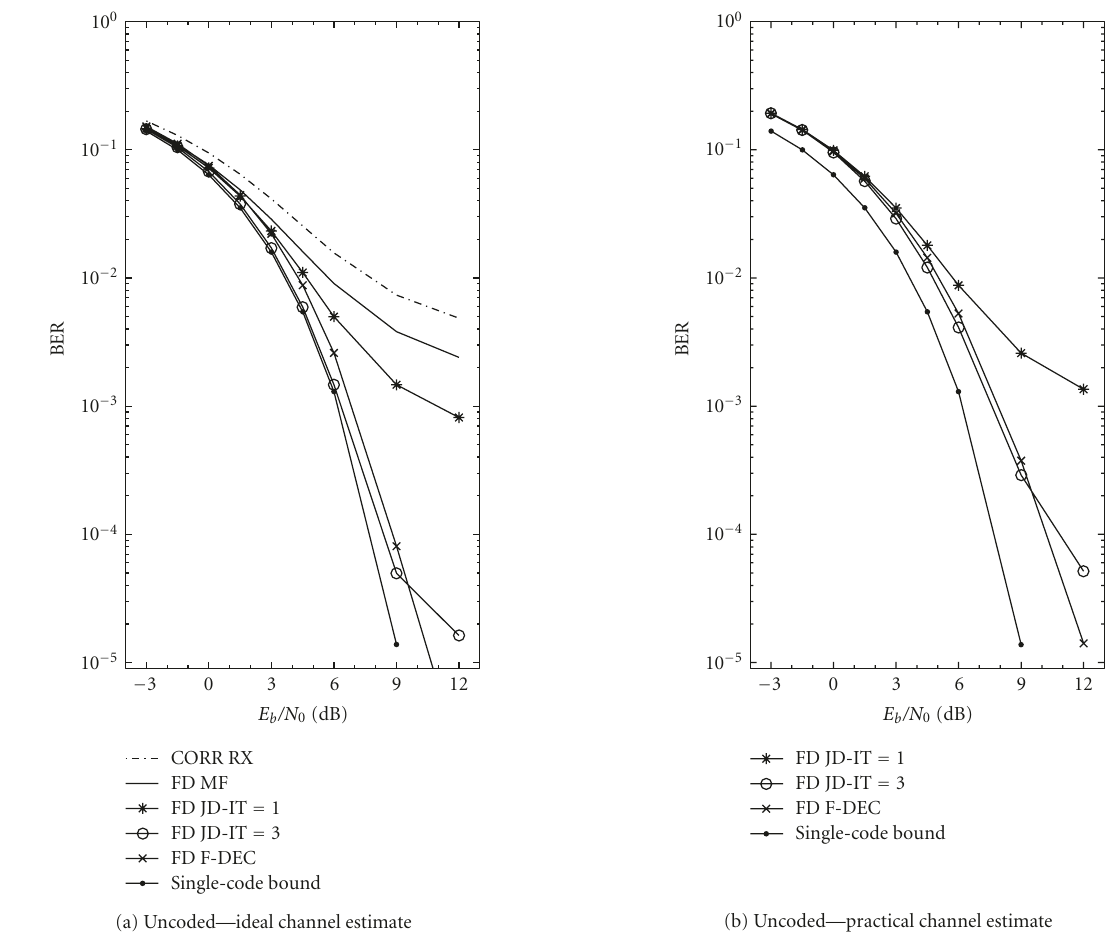
Figure 6: Average BER with one full-rate user without channel coding in